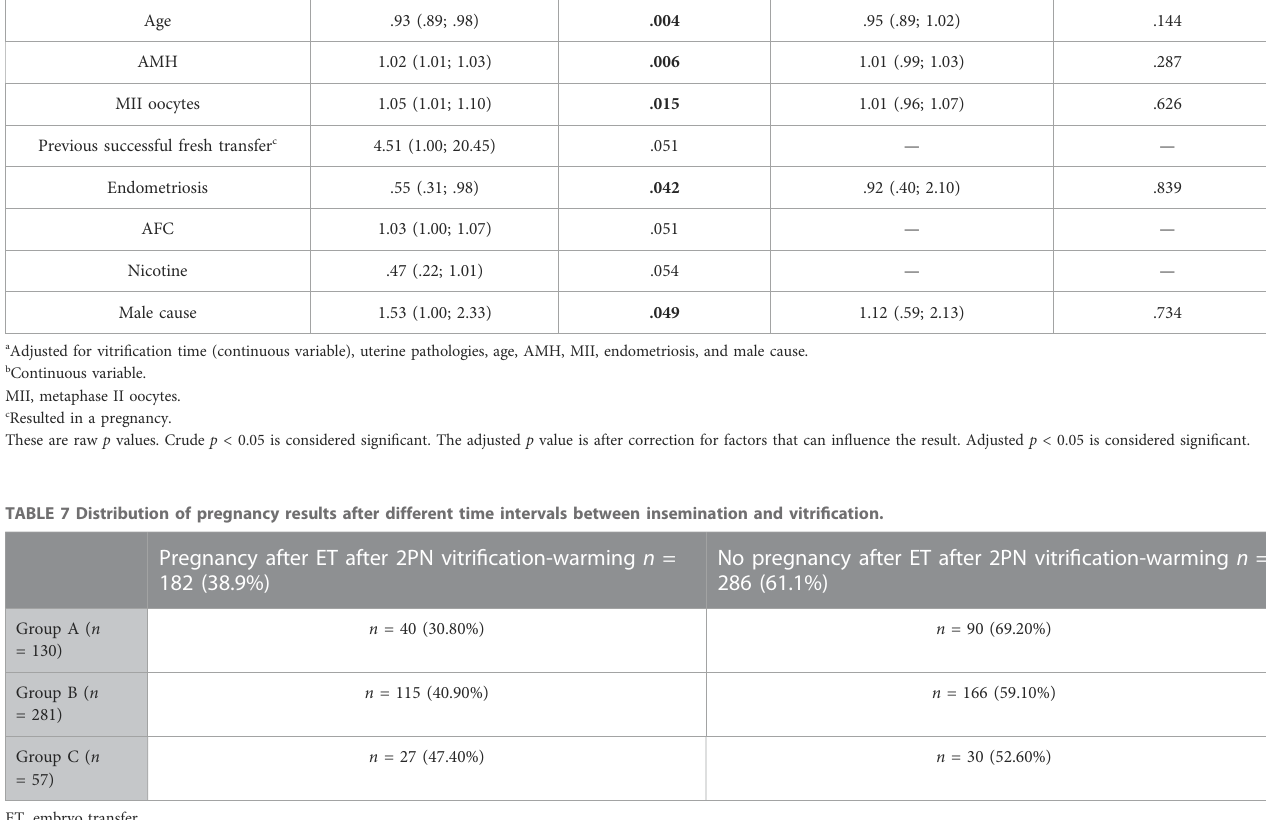
Uterine pathologies